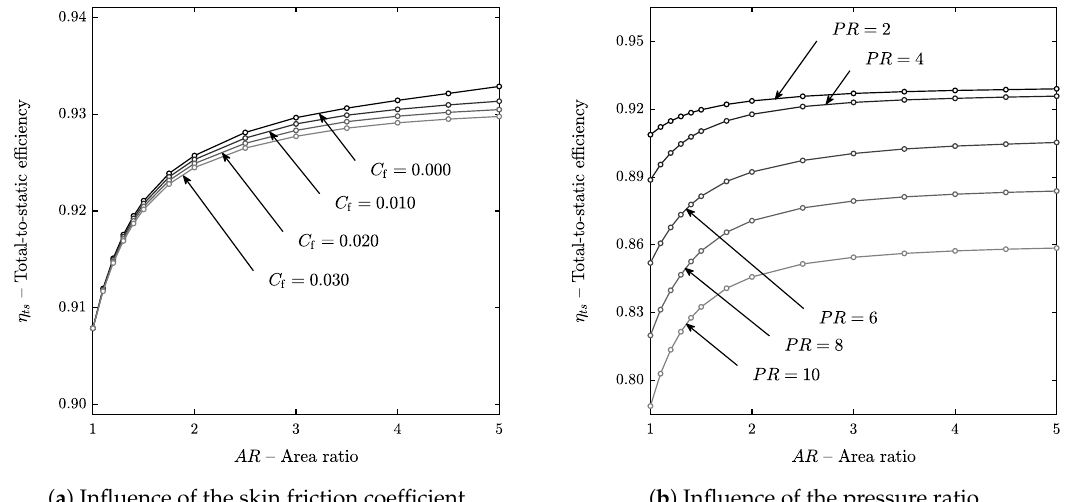
Figure 5. Total-to-static isentropic efficiency as a function of the diffuser area ratio and ( a ) skin friction coefficient or ( b ) pressure